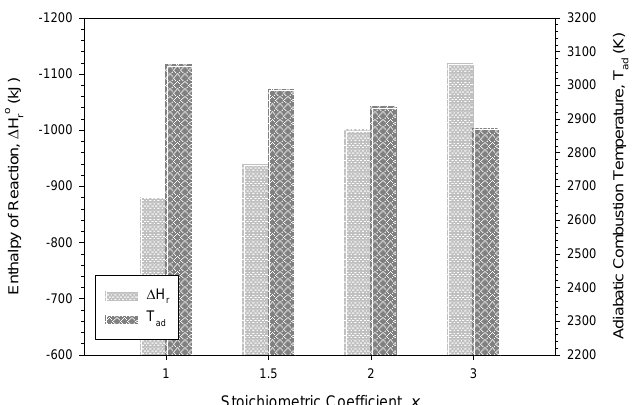
Figure 1. Enthalpy of reaction ( ∆ H ro ) and adiabatic combustion temperature ( T ad ) of Reaction (1) with different stoichiometric coefficients, x .